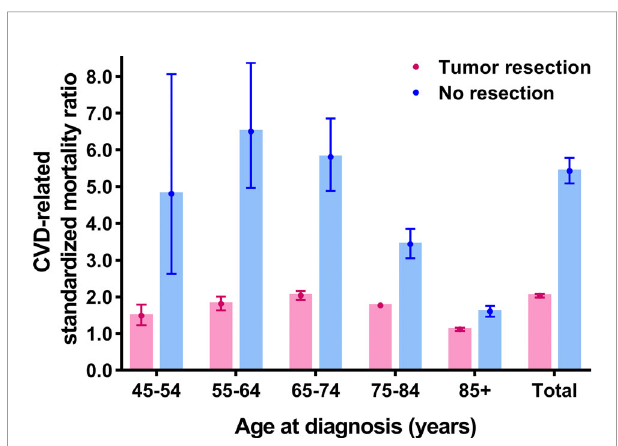
FIGURE 3 | Cardiovascular death (CVD)-related standardized mortality ratios (SMRs) for breast cancer patients with and without tumor